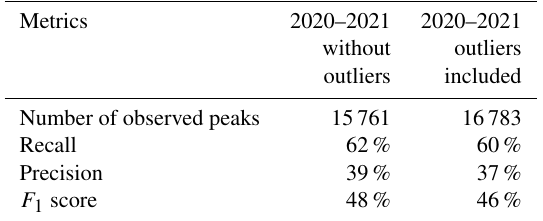
Table 3. Statistics for peaks greater than 10nSvh − 1 during the pe- riod 2020–2021 with and without the outlier stations. Metrics